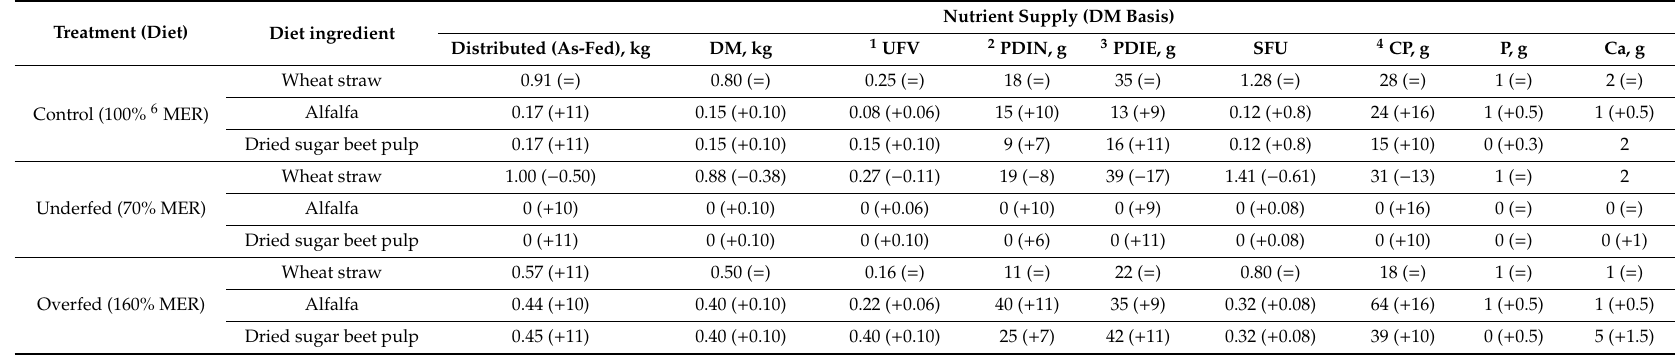
Table 2. Diet composition and daily nutrient supply (per ewe), according to the diet (treatment) applied during the challenge period (from day “zero” to 49). Values between brackets correspond to the added or reduced quantities (in percentage with regard to the “diet challenge” period) applied during the refeeding period (from day 49 till